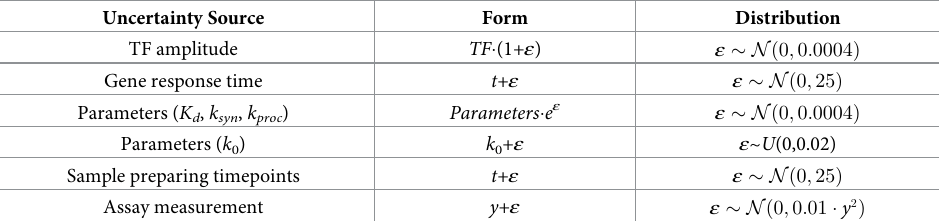
Table 3. Simulated